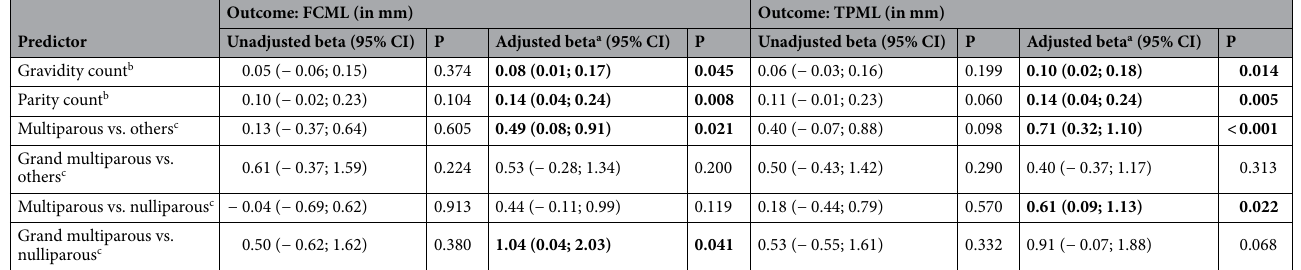
Table 2. Association between gravidity, parity and knee breadth dimensions among the study population. Beta coefficients from general linear models. Significant values are in bold. CI Confidence interval, FCML Femoral condylar mediolateral breadth, P P value, TPML Tibial plateau mediolateral breadth, Vs. versus. a Adjusted for height, weight, leisure-time physical activity, smoking, and education years. b Modelled linearly as a continuous variable. Beta coefficients are interpreted relative to one pregnancy/delivery. c Modelled as a binary variable. Beta coefficients represent mean difference between